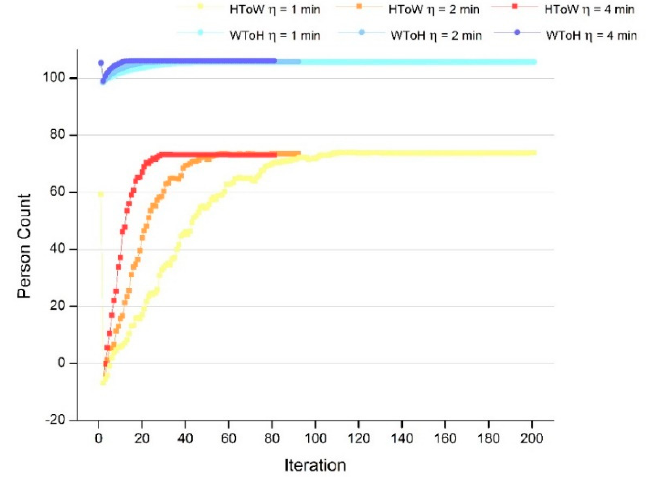
Figure 6. The average travel scores of the person agents in each iteration. HToW, home to work; WToH, work to home.